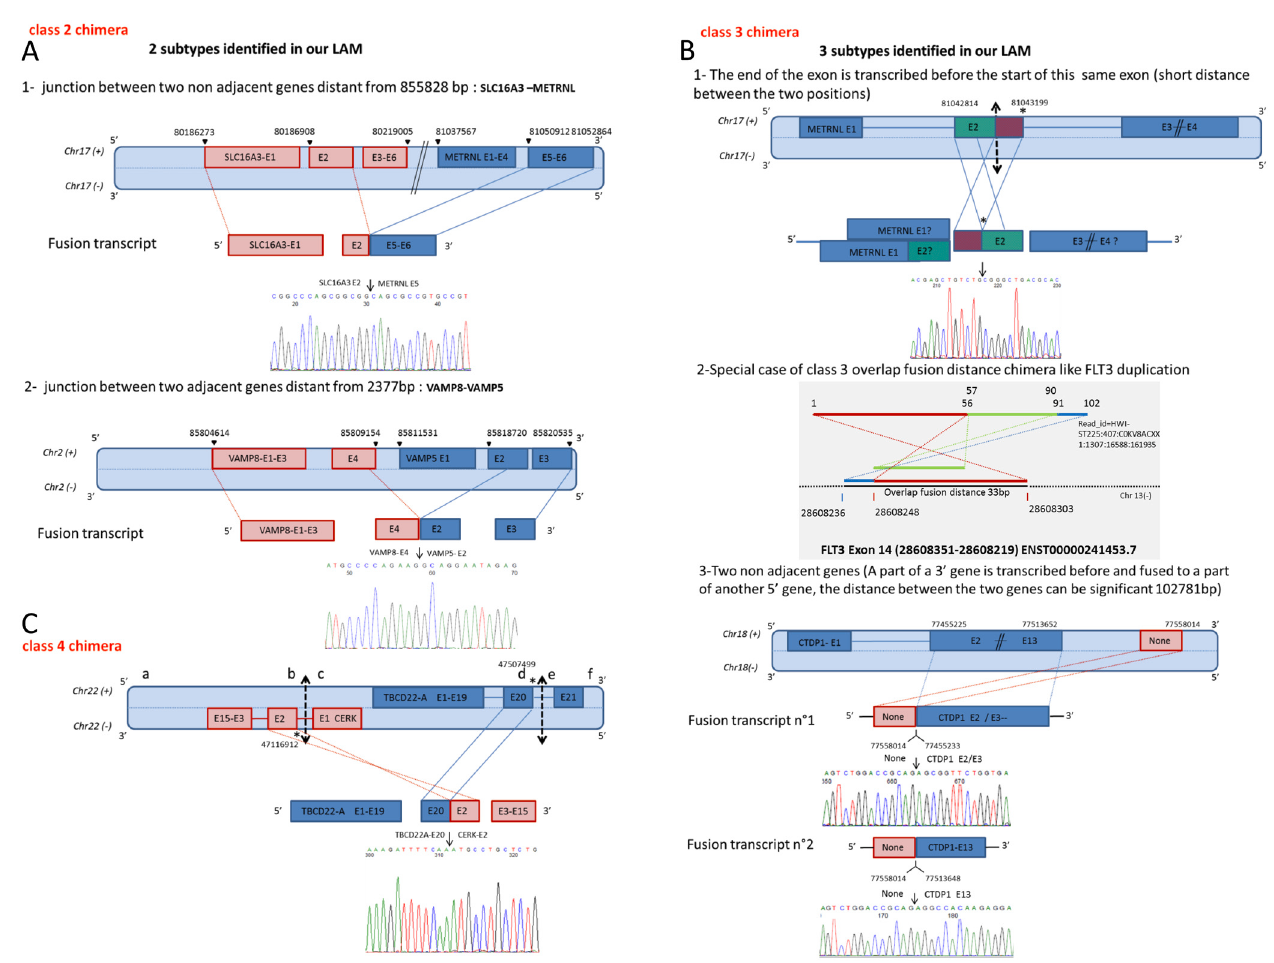
Figure 4. Different classes of validated chRNA. The position and orientation of the genes on the chromosomes have been schematically arranged. The start and end positions of the exons have been indicated. The representations of the chRNA junction supported by the Sanger sequencing results are also shown. ( A ) Two subtypes illustrating Class 2 chimera junctions. The first subtype 1 is illustrated by the junction of two non-adjacent genes SLC16A3 and METRNL, separated by 855828 bp. The second subtype 2 is illustrated by the junction between adjacent genes VAMP8 and VAMP5, separated by 2377 bp. ( B ) Three subtypes illustrating Class 3 chimera junction. They all involve the inversion of exon order, first two concern an inversion within a same exon of a gene (METRNL and FLT3 cases), and the third subtype involves an inversion of a transcribed sequence, separated by about 103 000 bp (NONE-CTDP1). ( C ) A Class 4 chimeric construction joining an exon from (+) strand gene TBCD22A with an exon from (-) strand gene CERK, arising from the same chromosome